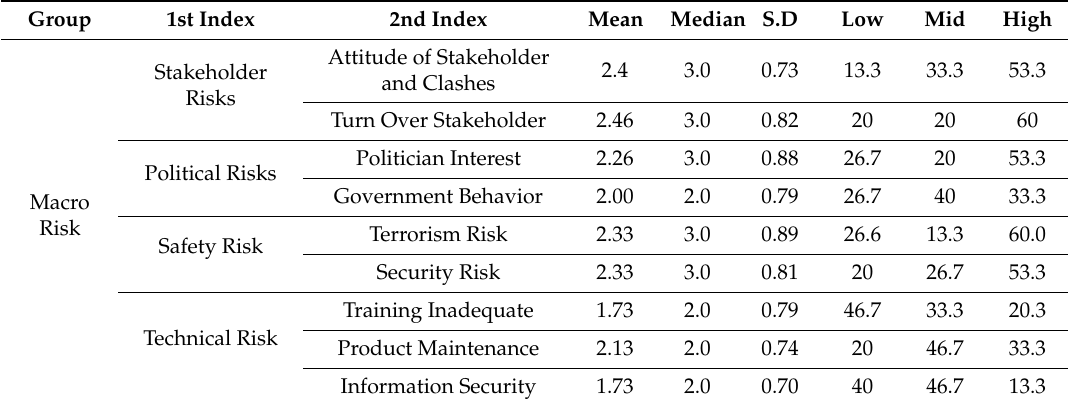
Table 3. Macro-level risk for round 1.